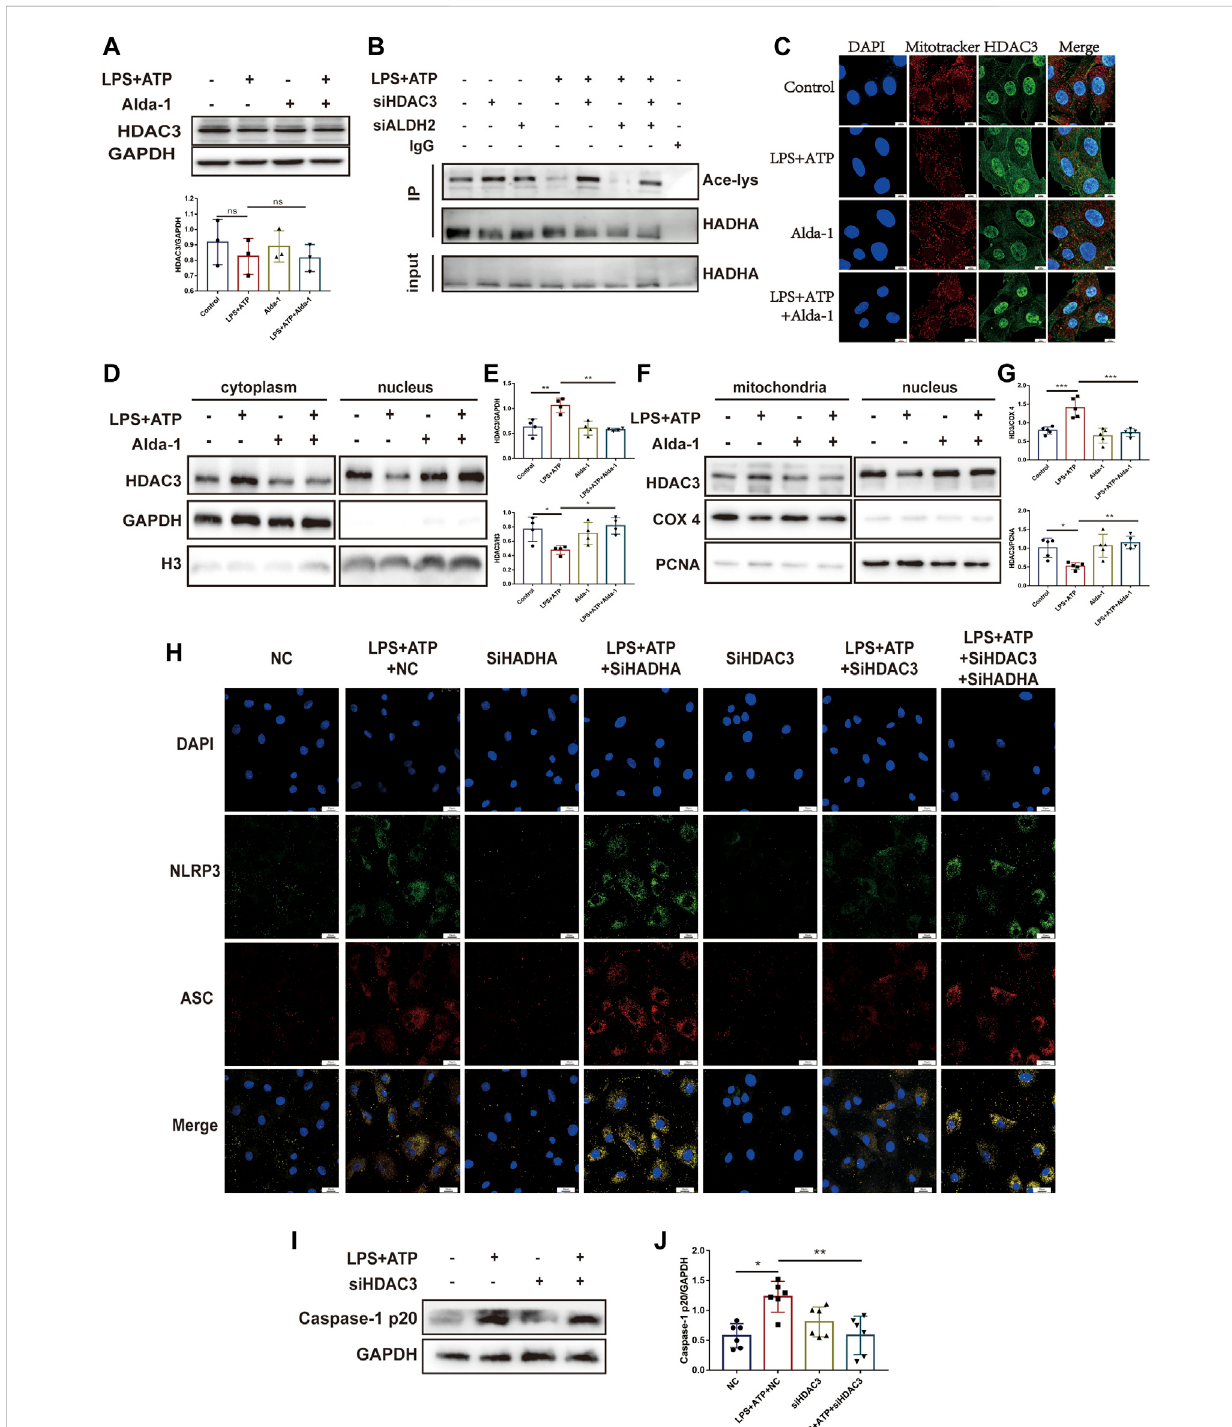
FIGURE 7 ALDH2 suppresses the translocation of HDAC3 from nucleus to mitochondria. (A) Total levels of HDAC3 and the quantitative analysis, n = 3 per group. (B) Representative immunoblots of HADHA acetylation levels in Hdac3 silenced or Aldh2 silenced or negative control H9C2 cells with or without LPS plus ATP stimulation, n = 3 per group. (C) Representative confocal images showing HDAC3 (green), Mito Tracker (red) and DAPI (blue), scale bar: 10 μ m. (D,E) Total levels of HDAC3, and the cytoplasmic and nuclear levels of HDAC3 proteins, and the quantitative analysis. Histone 3 and GAPDH were used as loading control of nuclear and cytoplasmic fractions, respectively, n = 3-4 per group. (F,G) The level of HDAC in mitochondrial and nuclei and the quantitative analysis. PCNA and COX4 were used as loading control of nuclear and mitochondrial fractions, respectively, n = 5 per group. (H) Representative immuno fl uorescence images showing NLRP3/ASC speck in Hdac3 silenced or Hadha silenced or negative control H9C2 cells with or without LPS plus ATP stimulation, scale bar: 25 μ m. (I,J) Representative immunoblots and the quanti fi cation of Caspase-1 p20 protein in H9C2 cells (GAPDH; loading control), n = 6, Mean ± SEM. **** p < 0.0001; *** p < 0.001; * p < 0.05; ns = not signi fi